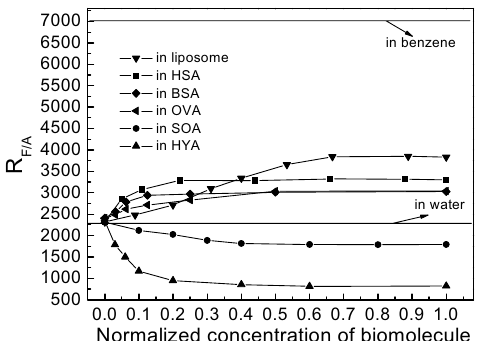
Fig. 9. R F = A values of HB (8 (cid:1) M) in benzene solution, water and plot of R F = A values of HB (8 (cid:1) M) as a function of nor- malized concentrations of liposome, HSA, BSA, OVA, SOA and HYA in PBS (pH ¼ 7.0).